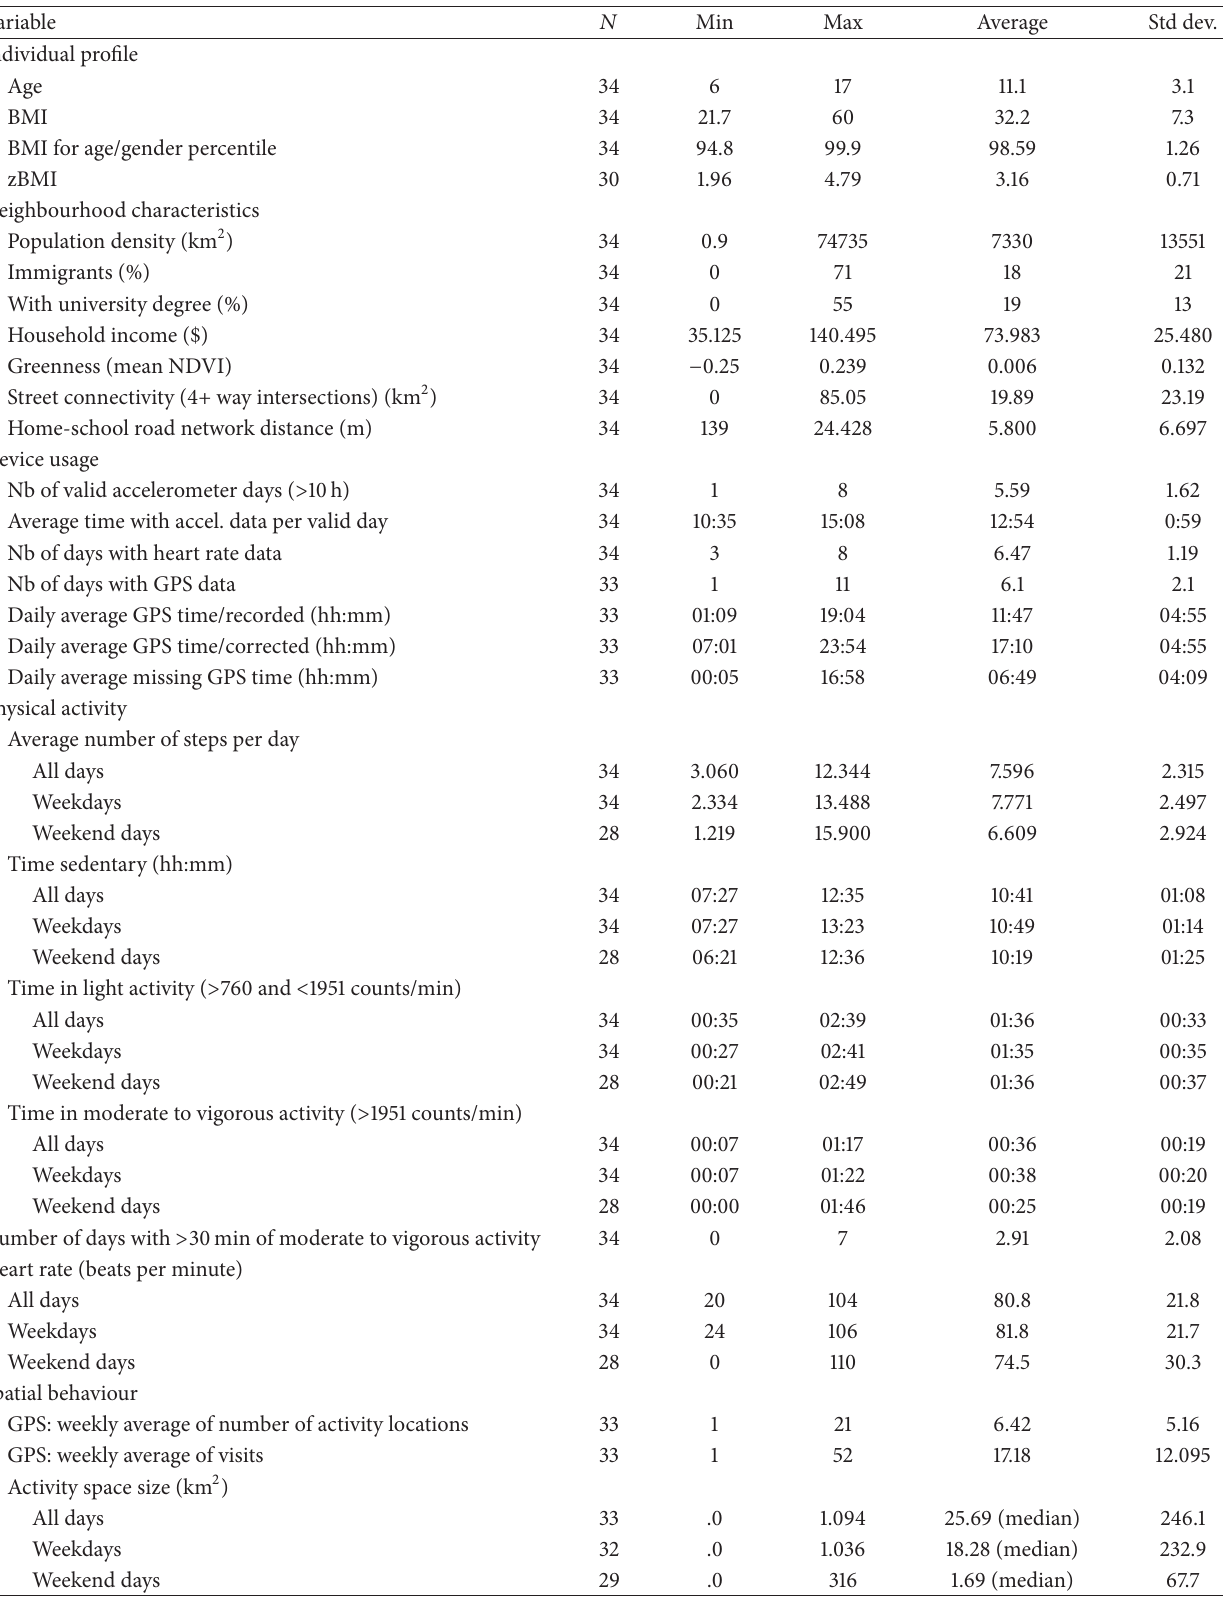
Table 1: Summary baseline statistics of Dyn@mo participant ( 𝑛 = 34